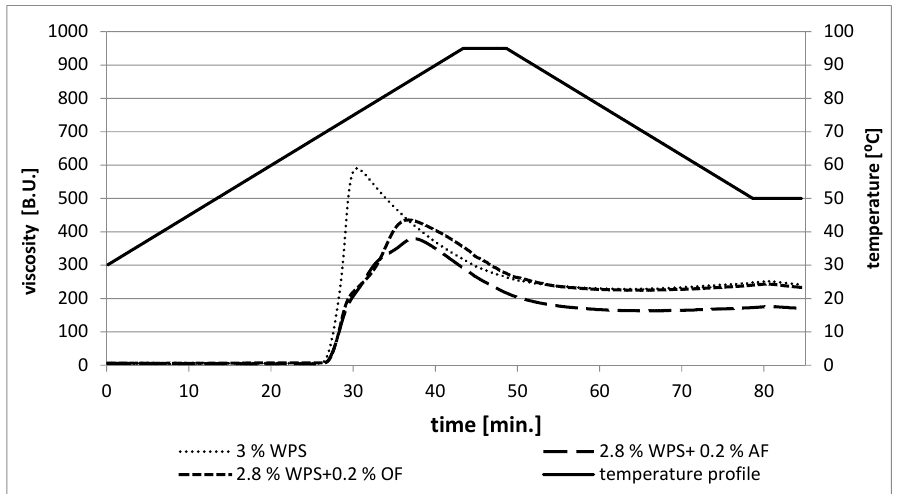
Figure 1. Pasting characteristics of 3% waxy potato starch and its mixtures with selected plant fibers (waxy potato starch (WPS), oat fiber (OF), apple fiber (AF)).